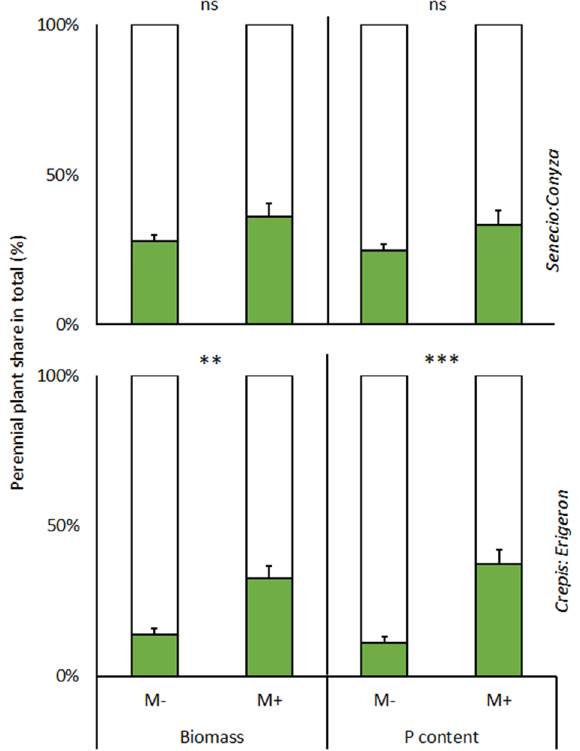
Figure 1. Fraction of shoot dry biomass and phosphorus content of perennial plants (gray bars) paired with weedy annual plants (white bars) as follows: Conyza canadensis-Senecio jacobaea ( Senecio:Conyza ) and Erigeron annuus–Crepis biennis ( Crepis:Erigeron ), determined by plant biomass at each cultivation (i.e., the share of resources acquired by the perennial plant on a whole cultivation basis, with the remainder assignable to the weedy annual plant) as affected by mycorrhizal inoculation (M+: mycorrhizal inoculum added; M−: nonmycorrhizal control). Bars represent means accompanied by standard errors (n = 10).